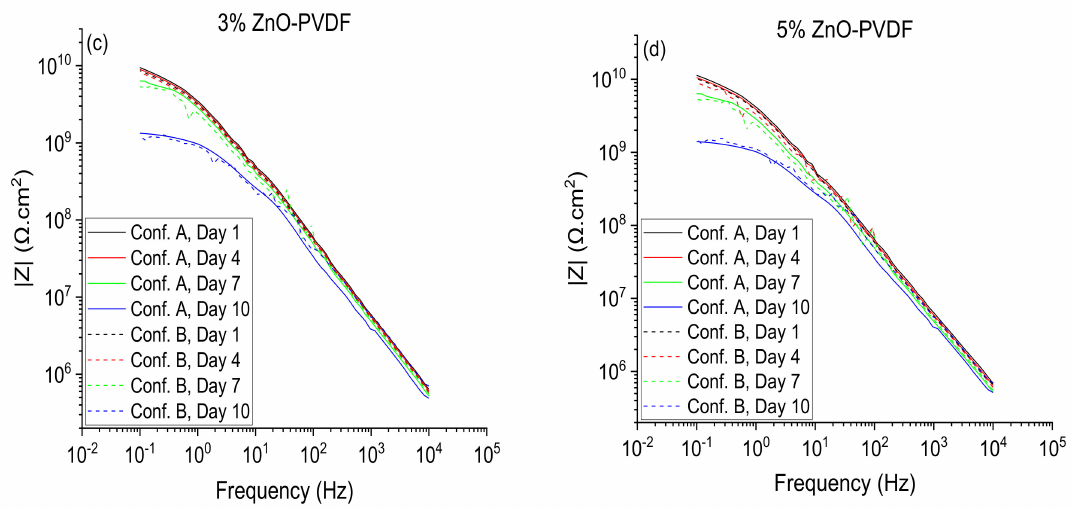
Figure 10. Instrument (solid lines) and sensor textile (dotted lines) Bode plots. ( a ) PVDF fiber, ( b ) 1% ZnO-PVDF fiber, ( c ) 3% ZnO-PVDF fiber, and ( d ) 5% ZnO-PVDF